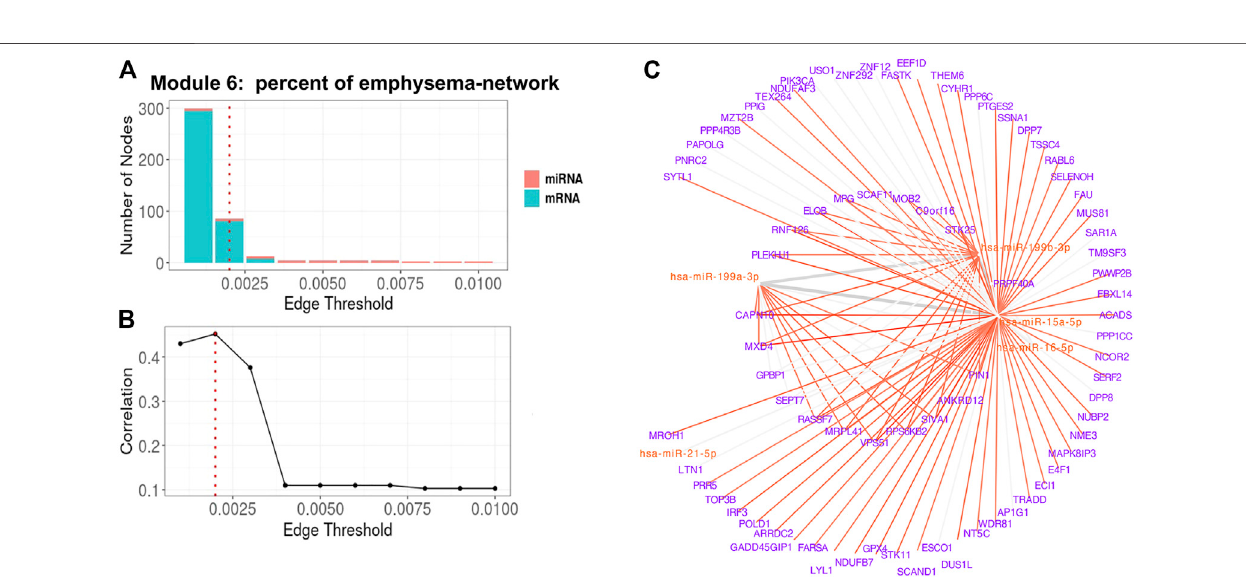
FIGURE 6 | Percent of emphysema-associated miRNA – mRNA network (Module 6 in Table 3 ) pruning with grid search. The edge threshold candidates were de fi ned bythedistributionoftheedgesinthe rawnetwork. (A) The number ofnodes including miRNA(red) and mRNA(light blue)with differentedge thresholds. (B) The absolutecorrelationbetweenpercentemphysemaandthe1stPC(i.e., fi rstprincipalcomponent)ofthetrimmednetworkunderdifferentedgethresholds.Thereddotted line indicated the chosen optimal edge threshold (0.002) for network trimming, which achieved a maximum correlation (0.35) between FEV 1 pp and the 1st PC. (C) The trimmed miRNA – mRNA network (module 6 in Table 3 ) with the optimal edge threshold (0.002). The signs of edges are based on the correlation of the original expression data between the nodes. Red and blue edges represent negative and positive correlations respectively. Edge thickness corresponds to the relationships between the nodes based on the canonical